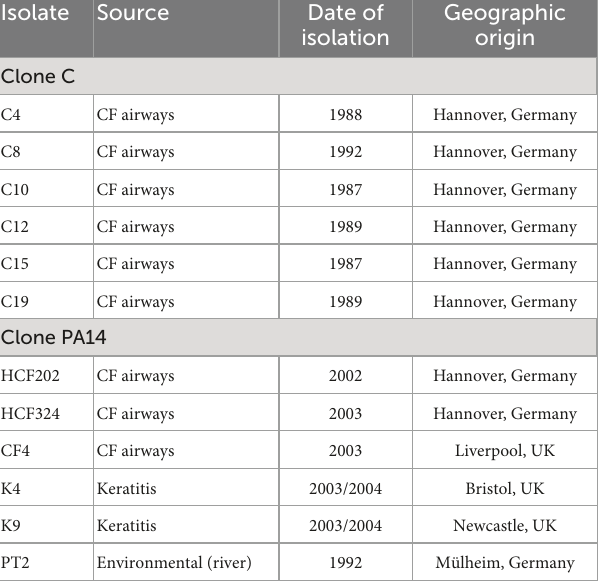
TABLE 1 Isolates analyzed by long-read